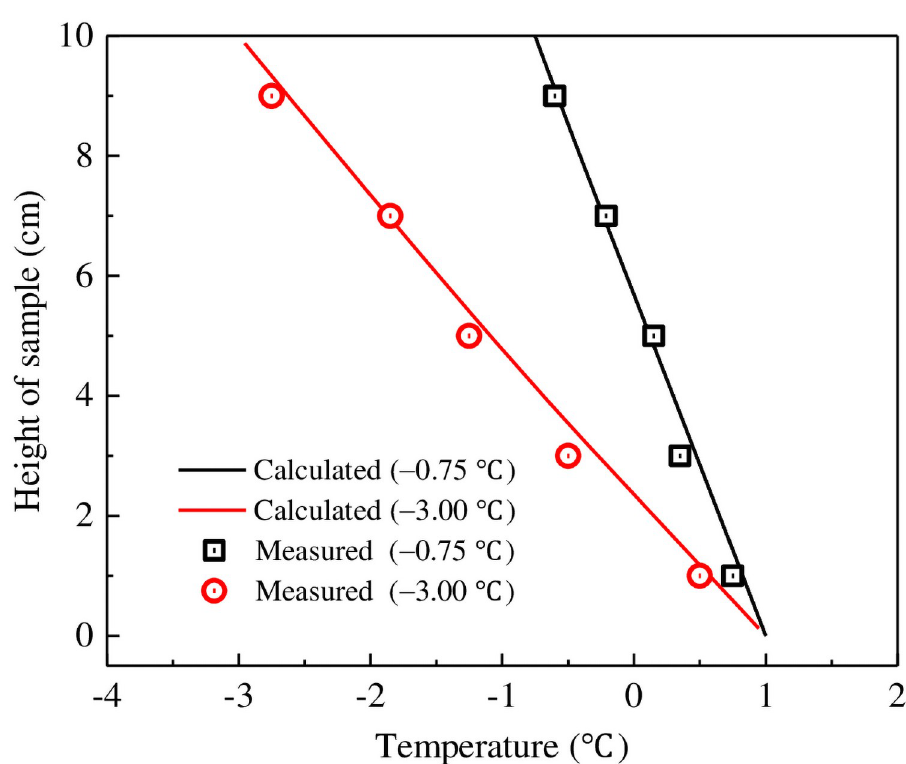
Fig 6. Temperature profiles within each soil sample after the freezing